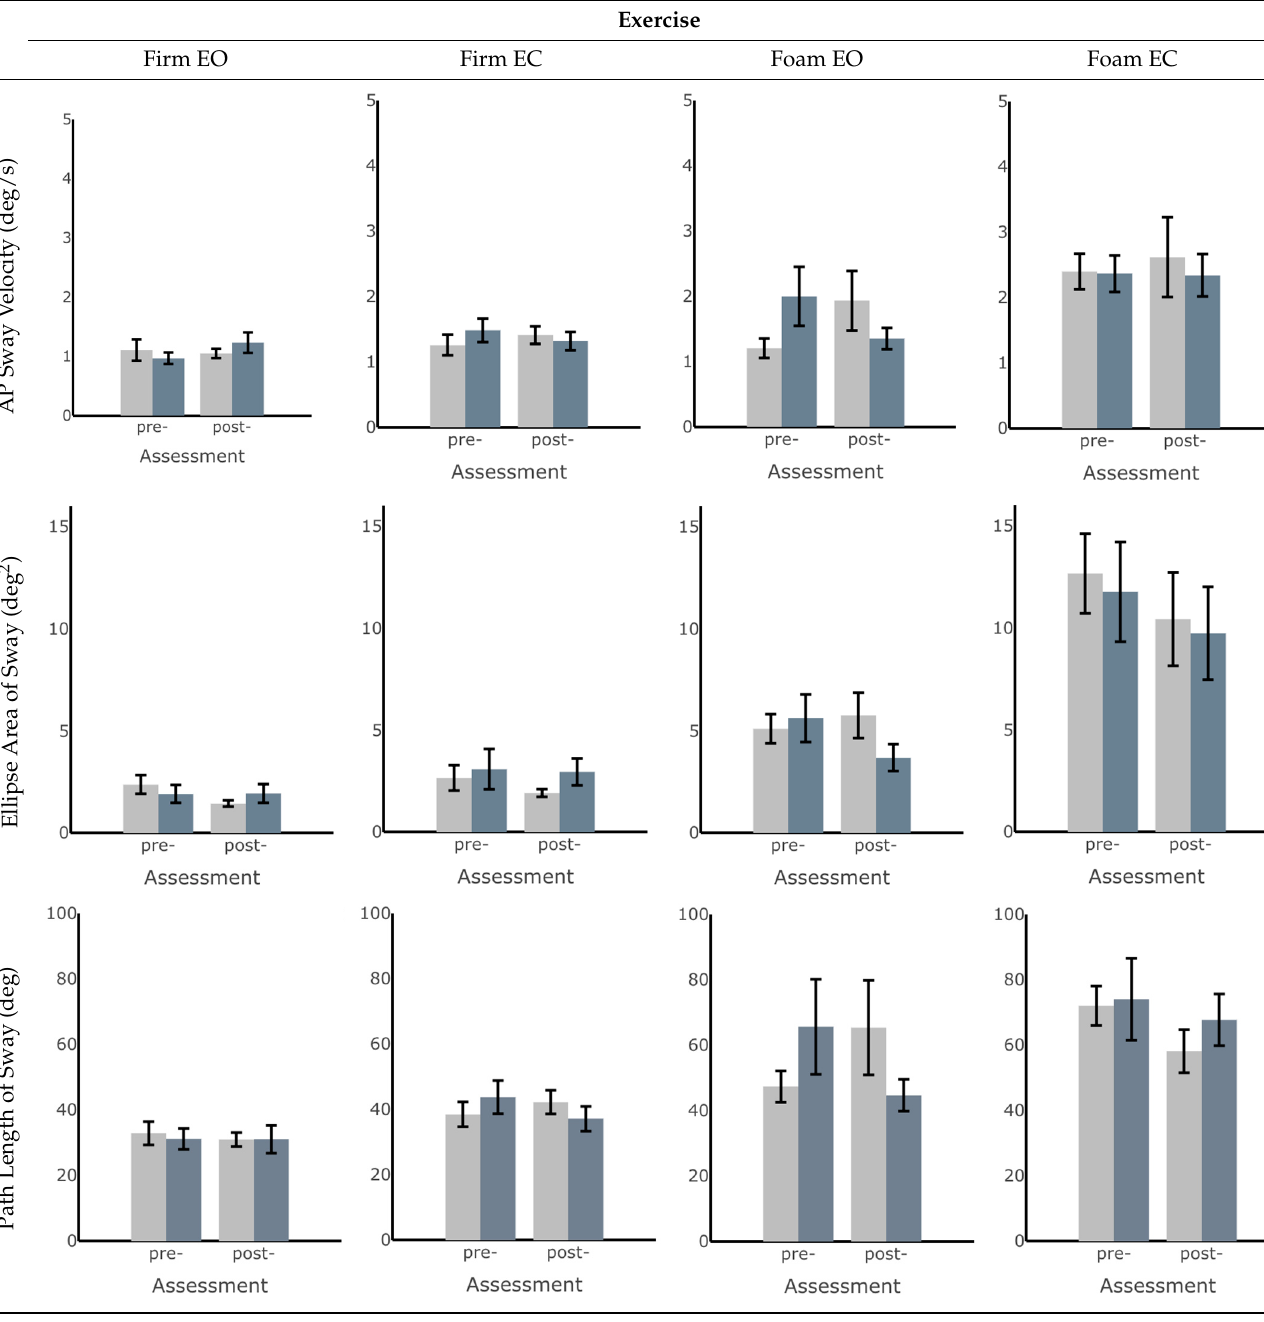
Table A1. Cont. Exercise Exercise Exercise Exercise Exercise Exercise Exercise Exercise Foam EO Foam Firm EC Foam EO Foam EC Firm EC Foam EO Foam EC Firm EC Foam EO Foam EC Foam EO Foam EC Firm EC Foam EC Firm EC Foam EO Foam EC Firm EC Foam EO Foam EC